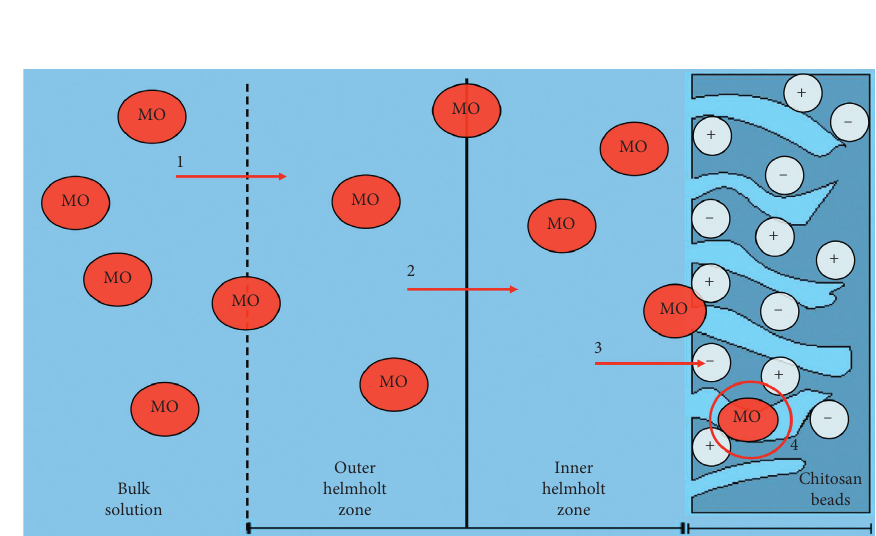
Figure 8: Diffusion steps of methyl orange from the bulk solution into cross-linked chitosan beads (1- bulk diffusion, 2- film diffusion, 3- intraparticle diffusion, and 4- adsorption on chitosan